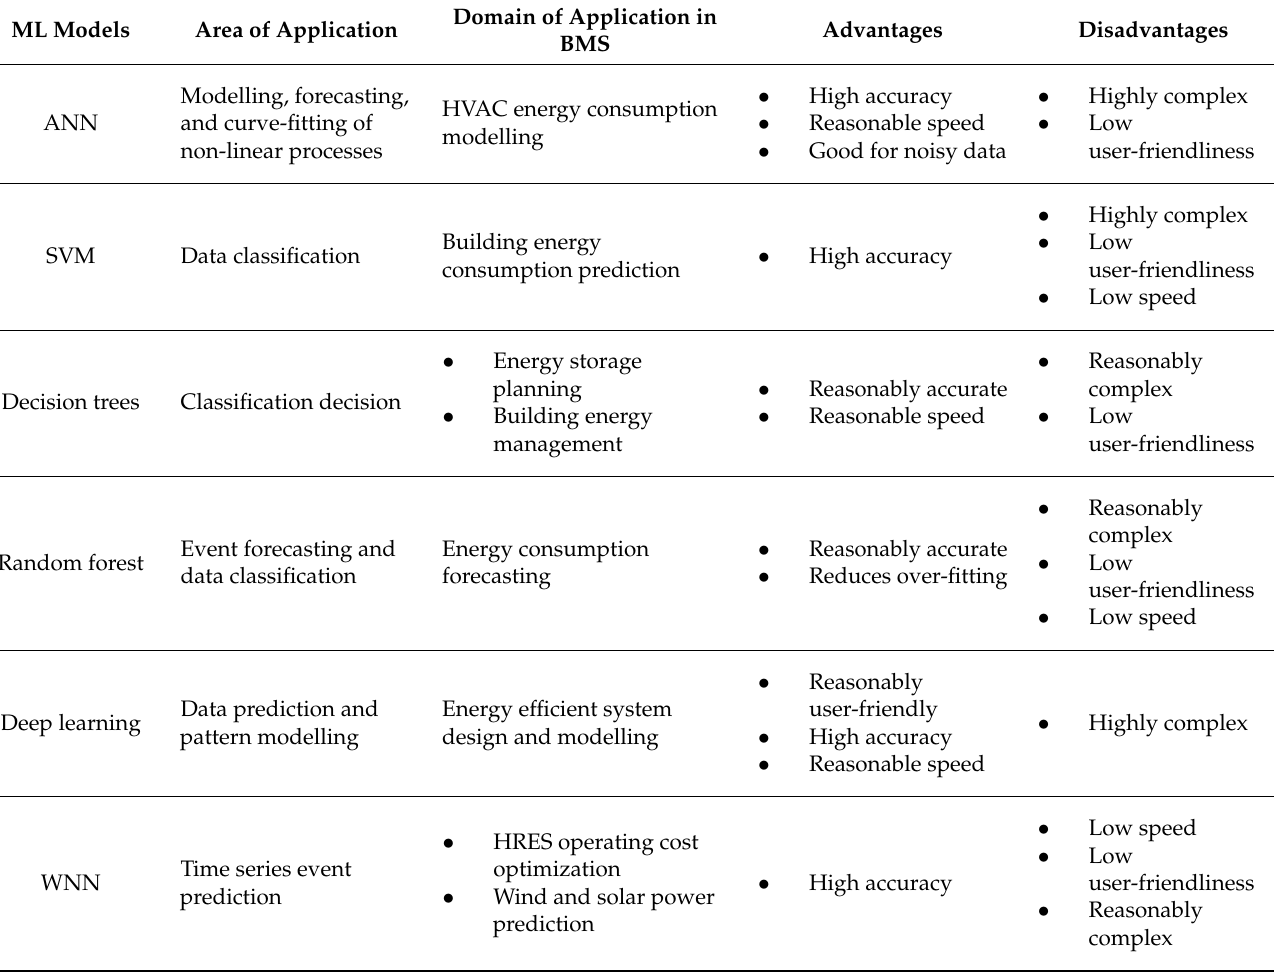
Table 2. Comparison and applications of different machine learning models in smart